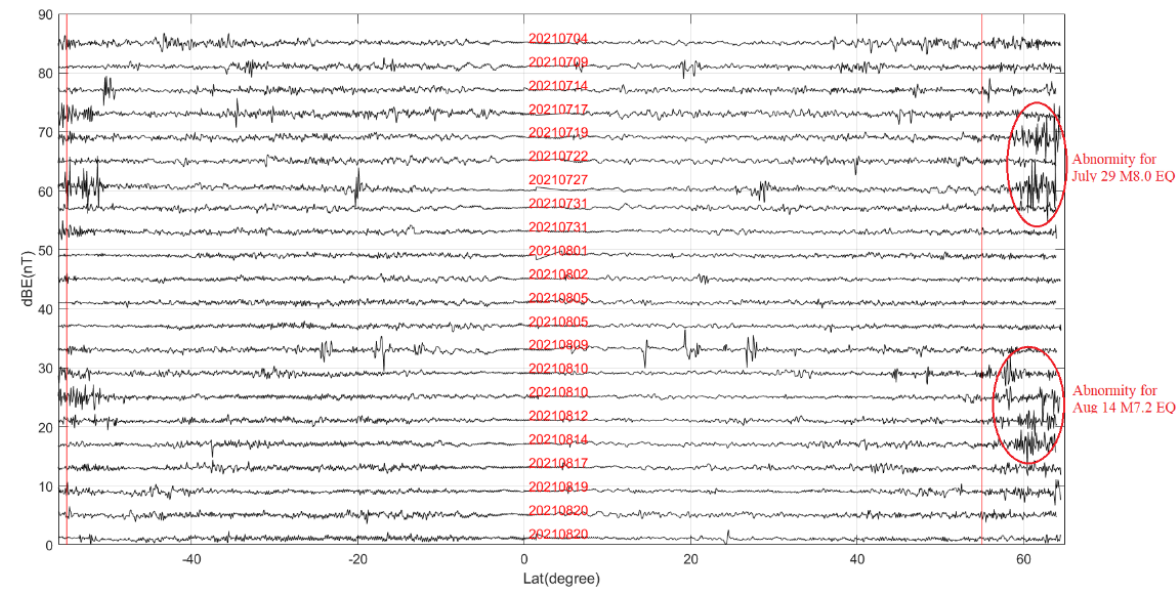
Figure 5. The abnormal ULF waves emitted before the 2021 M 8.1 and M 7.0 EQs in Alaska.